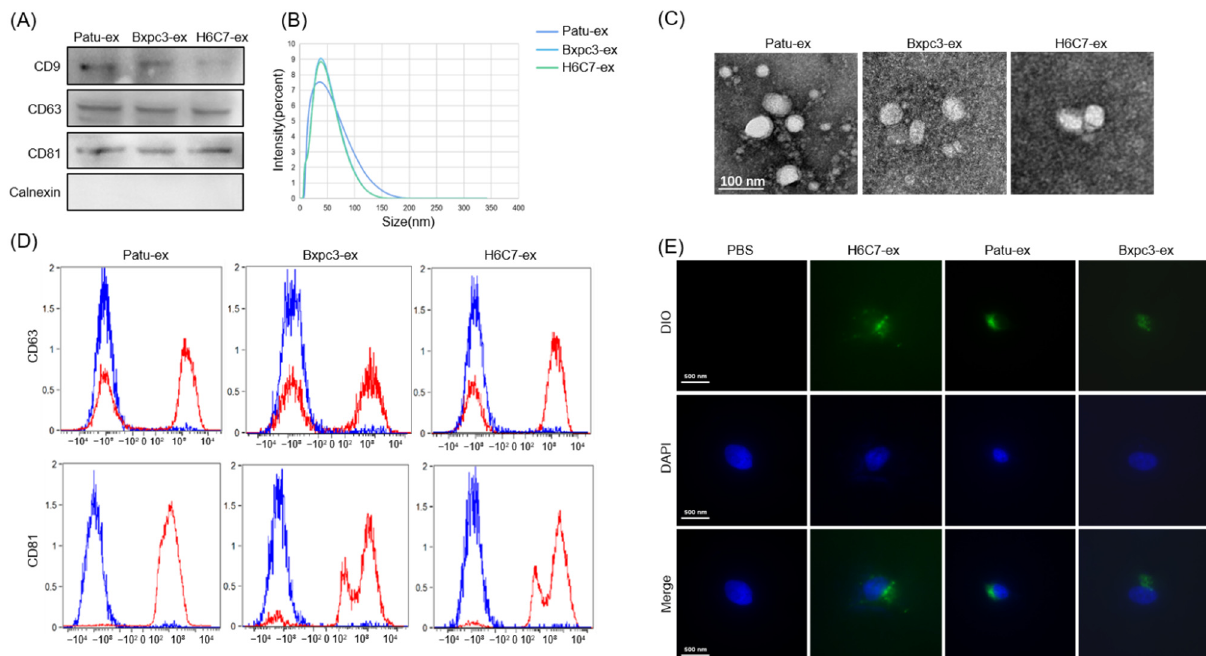
Figure 1. Identification of exosomes from pancreatic cancer cells. ( A ) The marker proteins of exosomes CD9, CD63, and CD81 were tested via Western blotting. ( B ) The size of exosomes was detected by the nanoparticle tracking analysis (NTA) assay. ( C ) The form of exosomes was observed under a transmission electron microscope (TEM). ( D ) Flow cytometry was performed to determine the marker proteins CD63 and CD81. Exosome samples were labeled in red and PBS was labeled in blue. ( E ) After dying with DIO, the exosomes were taken up by human lymphatic endothelial cells (HLEC). The pictures were taken with a confocal laser scanning microscope.